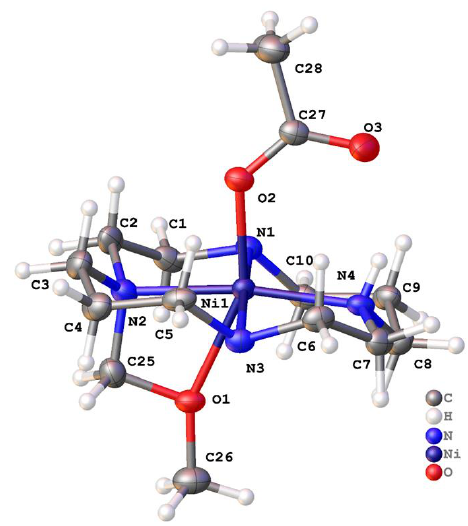
Figure 12. Structure of 2′ , the -CH 2 OCH 3 modified version of 2 , which occurred spontaneously during the recrystallization of [Ni( 2 )(OAc)]PF 6 from MeCN. Coordination about the metal in [Ni( 2′ )(OAc)] + cation. For clarity, the benzyl groups attached to N1 and N3 are not shown.